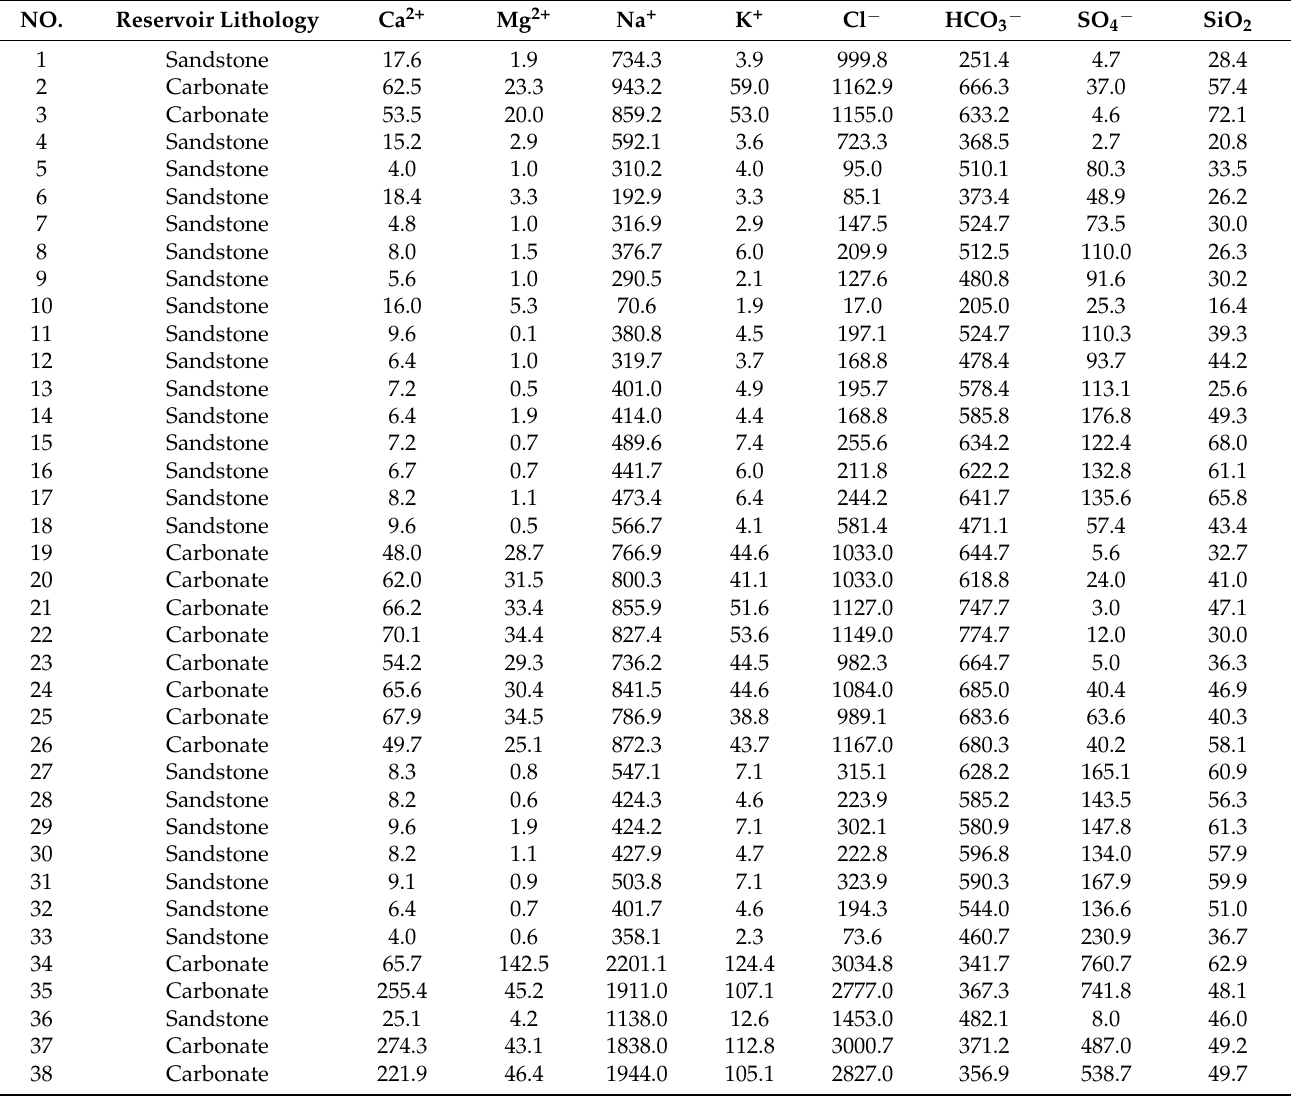
Table 1. Table of major ion concentrations in geothermal fluids